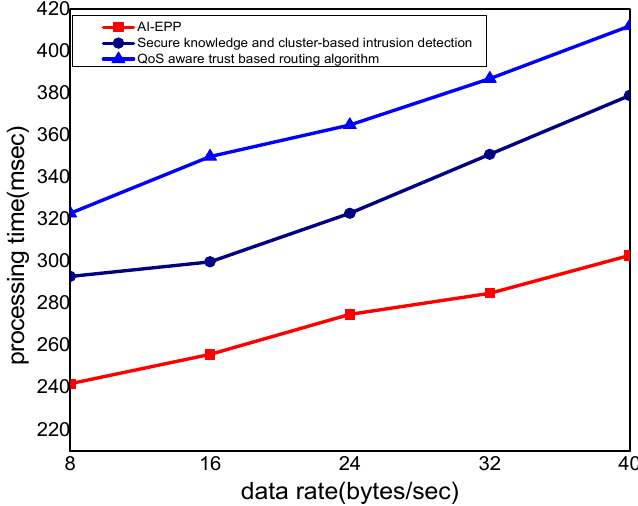
Figure 15. Processing time comparison using simulations with varying number of nodes.